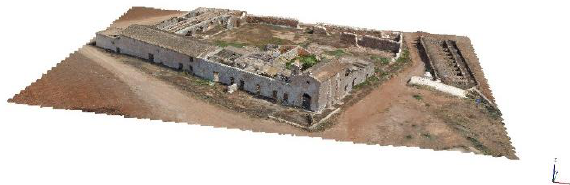
Fig. 9. Dense point cloud obtained from the photogrammetric